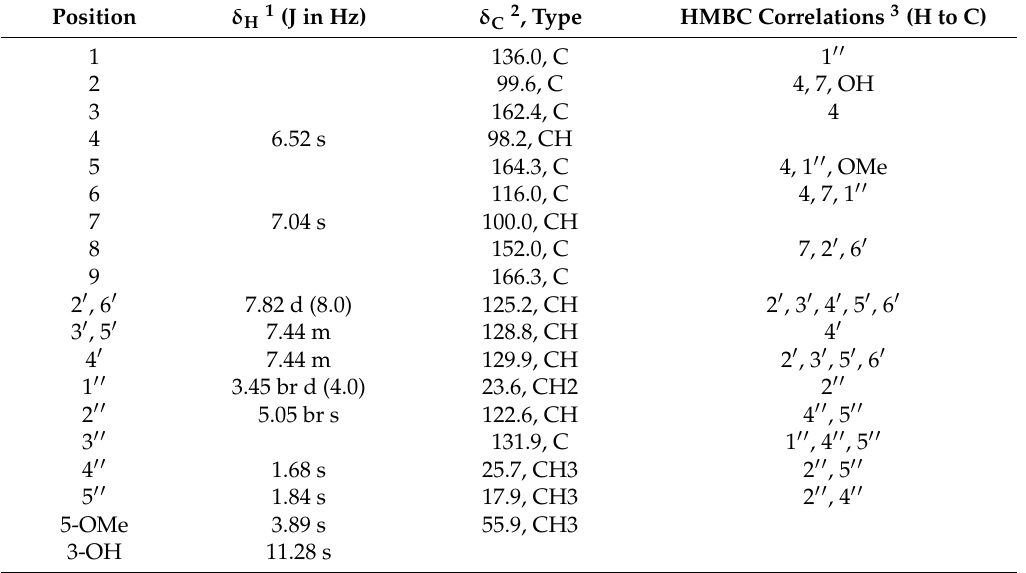
Table 1. 1 H NMR, 13 C NMR, and HMBC data of CLA measured in CDCl 3 ( δ